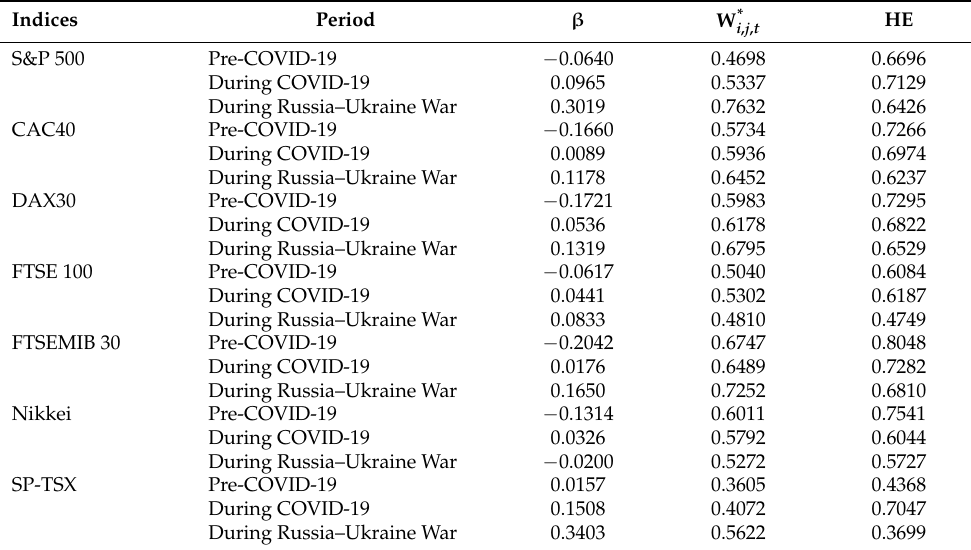
Table 5. β , W ∗ , and HE for a Gold–G7 indices i , j , t